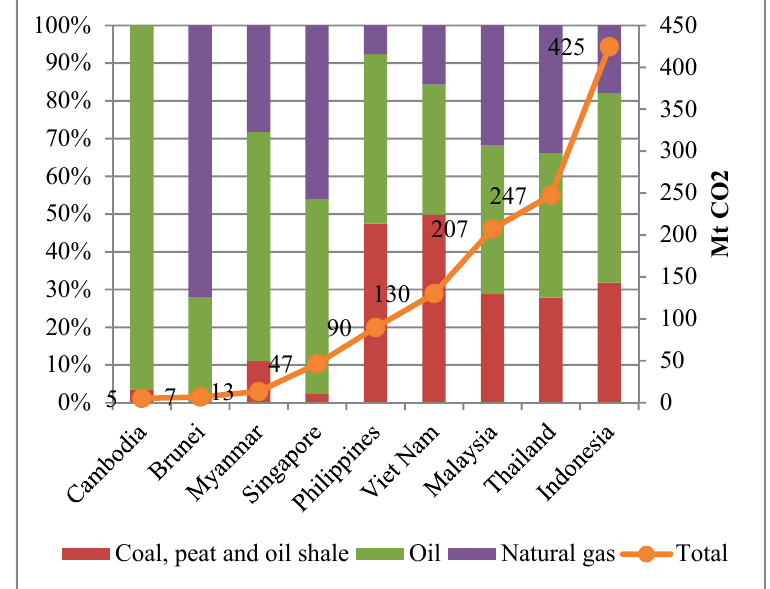
Figure 6. CO 2 emissions contribution by source of energy in 2013 (calculated from IEA database 2015).